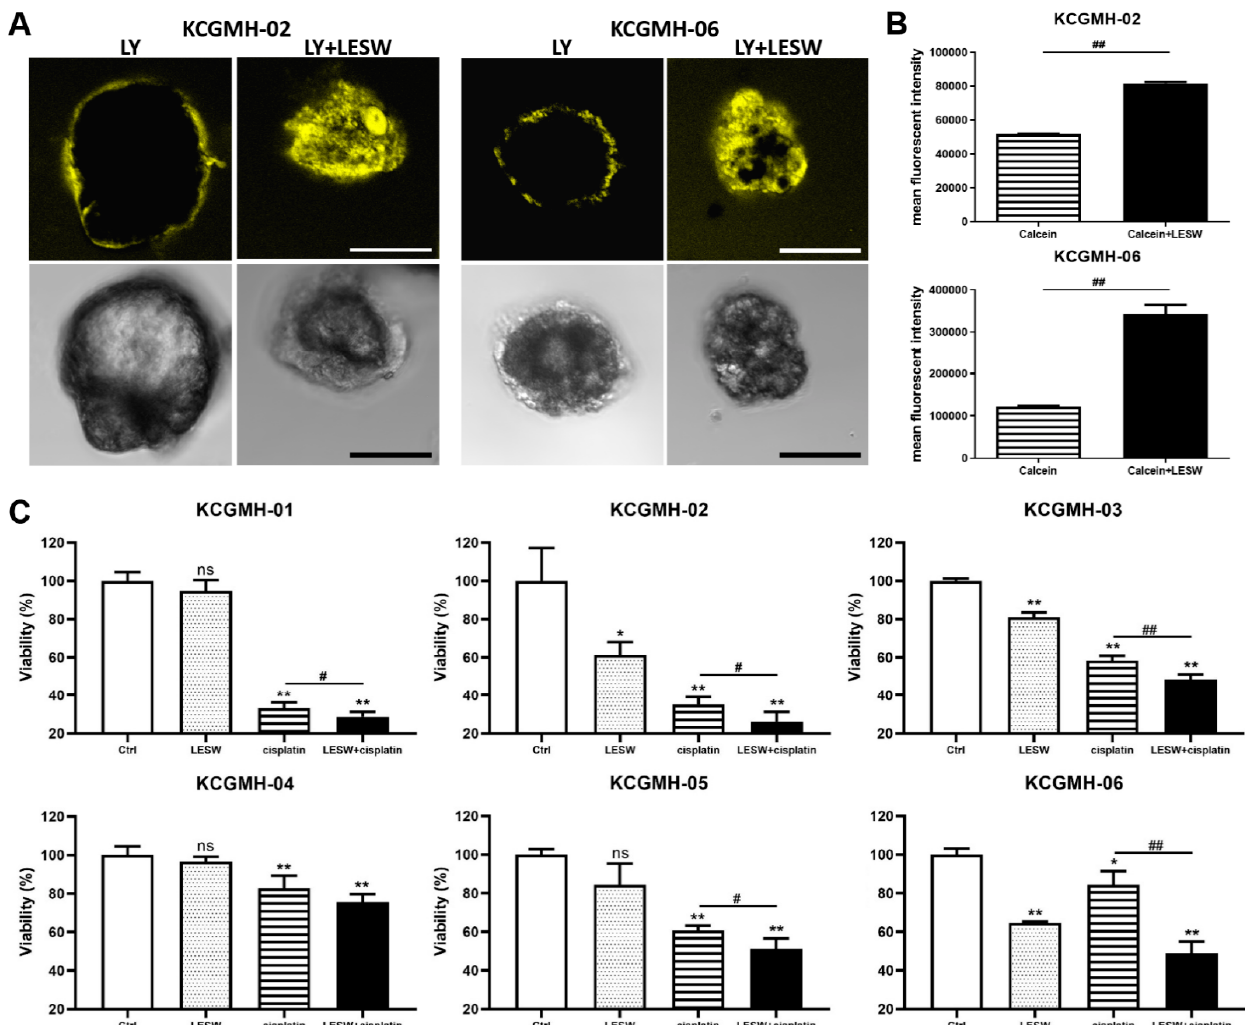
Figure 7. Shock waves enhanced cisplatin cytotoxicity in a patient-derived organoid (PDO) model of UTUC. ( A ) Confocal fluorescent images for KCGMH-02 and KCGMH-06 organoids in the presence of Lucifer yellow (LY) treated with or without 200 shock wave pulses at 0.12 mJ/mm 2 . (yellow: Lucifer yellow, size bar = 20 µ m). ( B ) KCGMH-02 and KCGMH-06 organoids were treated with 0.2 mM Calcein combined with 200 shock wave pulses at 0.12 mJ/mm 2 and assessed by flow cytometry. Data are denoted as mean ± SEM, n = 3, the p values were calculated with Student’s t-test, ## p < 0.01 versus Calcein group. ( C ) Combined treatment with cisplatin and LESW augmented the effect of cisplatin on cell viability in the PDO model. Six independent PDOs were treated with 200 shock wave pulses at 0.12 mJ/mm 2 , cisplatin, or 200 shock wave pulses at 0.12 mJ/mm 2 plus cisplatin. KCGMH-01 was treated with 4 μ M cisplatin, and the other PDOs were treated with 0.16 μ M cisplatin. Cell viability was measured using the CellTiter-Glo assay after six days of cisplatin treatment. Values are mean ± S.E.M. of three biological replicates. Error bars represent the mean ± S.E.M., the p values were calculated with one-way ANOVA followed by Tukey’s multiple-comparison test, * p < 0.05, ** p < 0.01 versus control group, ns indicates no significance, # p < 0.05 versus CDDP group, ## p < 0.01 versus CDDP group.